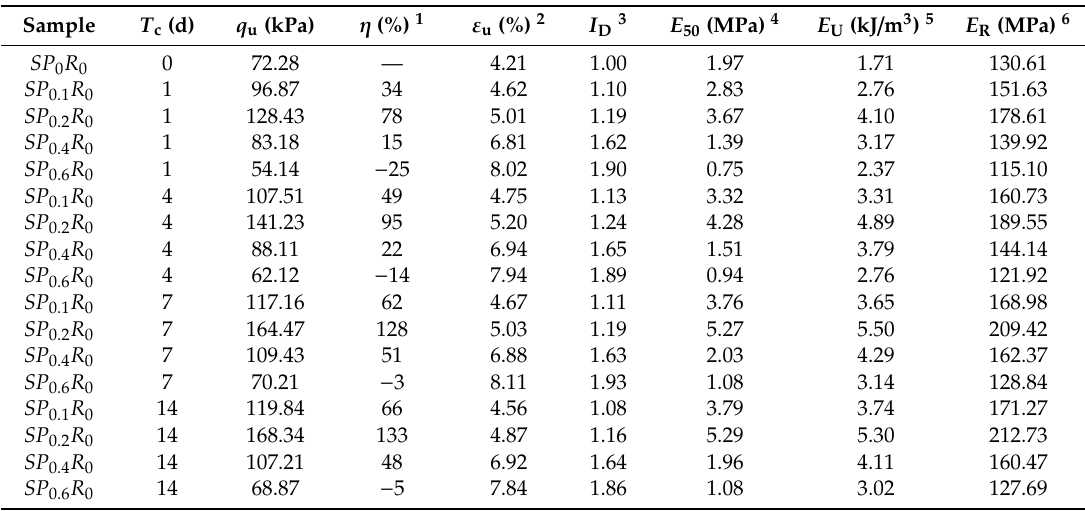
Table 7. Summary of the stress–strain features for the natural soil and various PAM-treated samples— SP x R 0 where x = {0, 0.1, 0.2, 0.4, 0.6}—at T c = 1, 4, 7 and 14